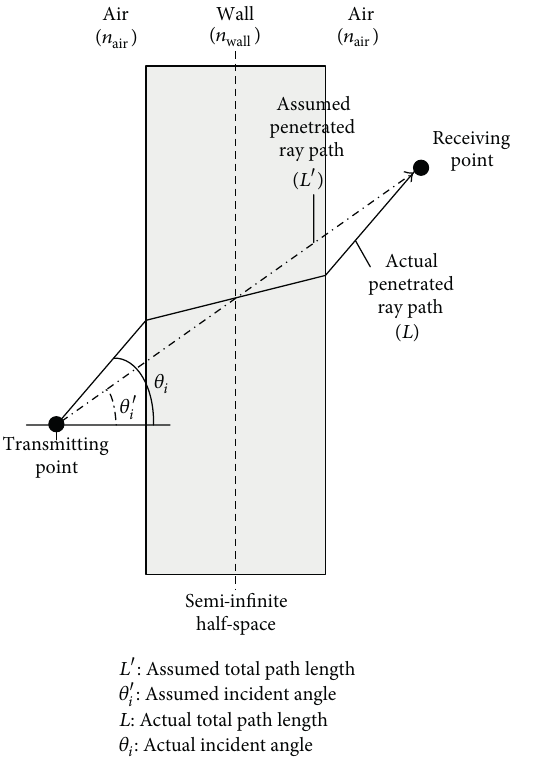
Figure1:Comparisonbetweenanassumedraypathinconventional ray tracing and an actual ray path for penetration through the wall.